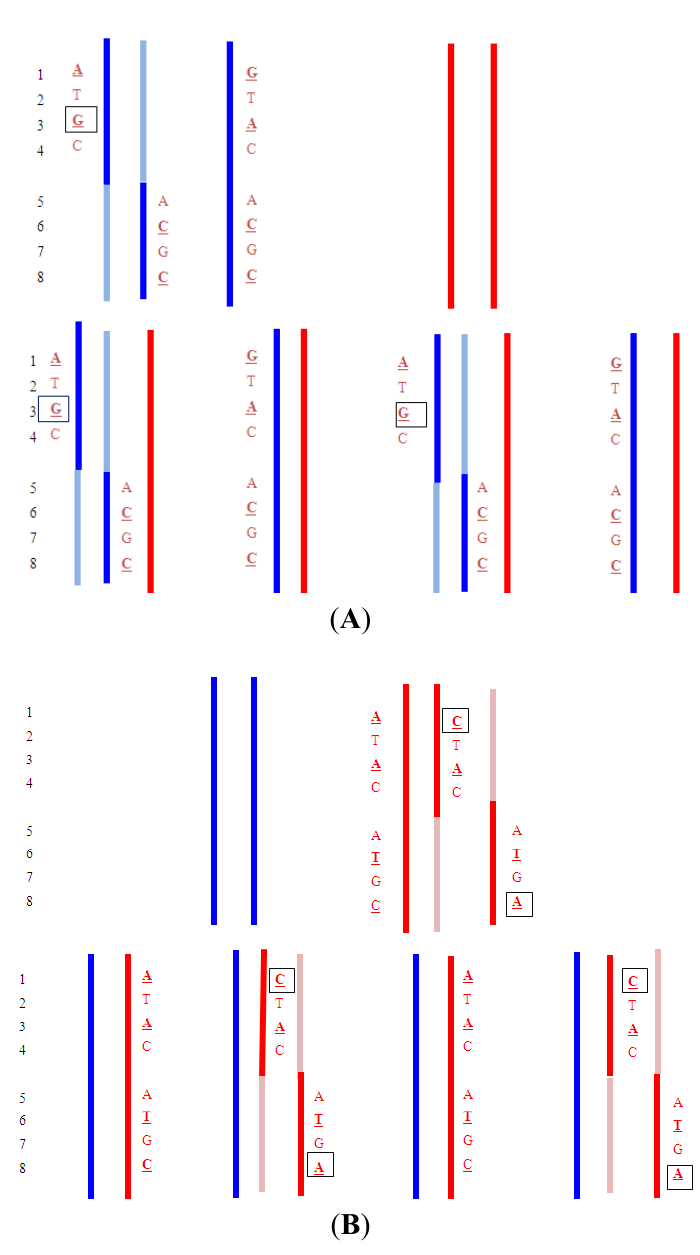
Figure 5. ( A ) Detection of a paternally inherited balanced translocation; ( B ) Detection of a maternally inherited balanced translocation.